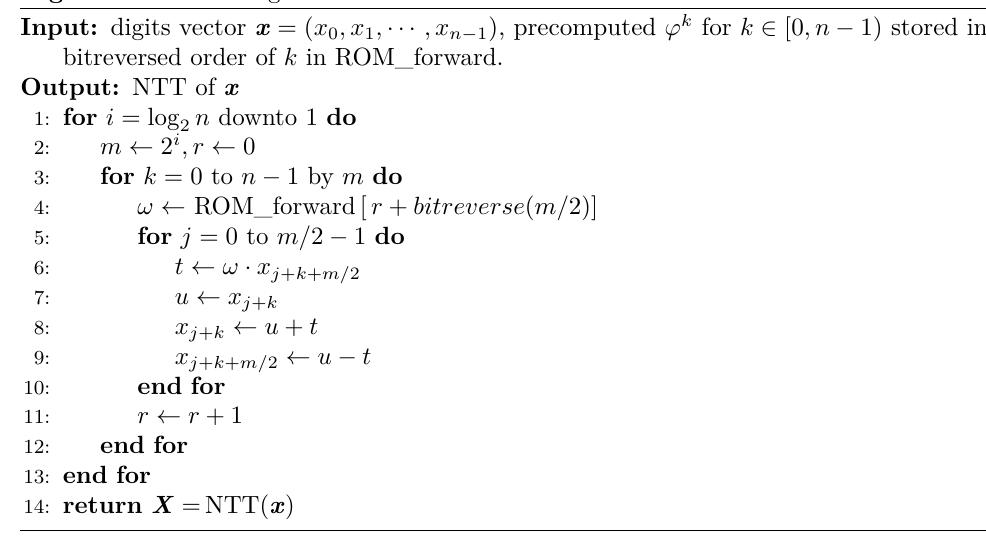
Algorithm 2 Rearranged Iterative DIT NTT